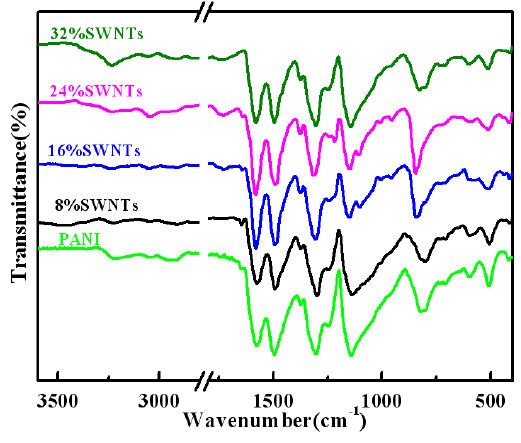
Figure 1. Fourier transform infrared (FTIR) spectra of polyaniline (PANI) and